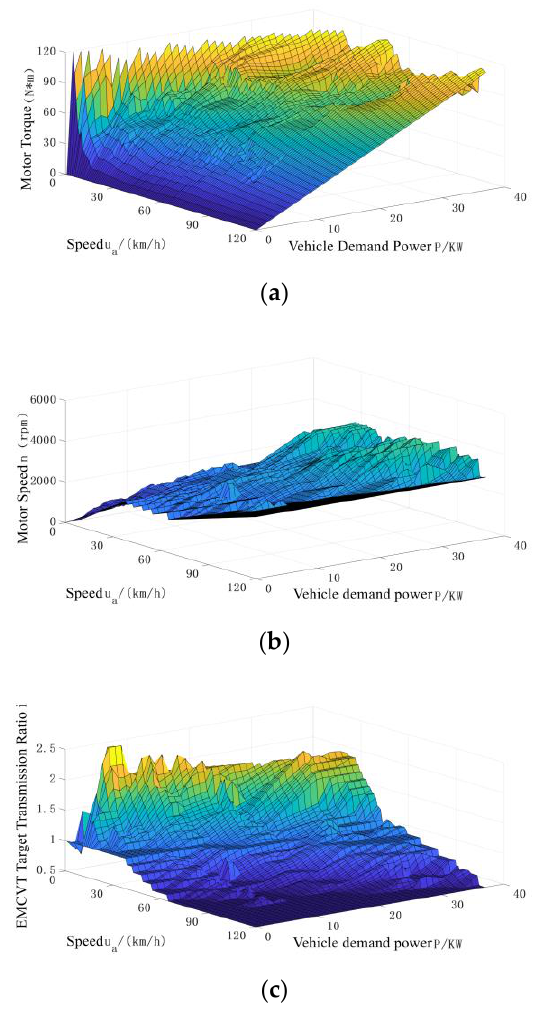
Figure 7. The calculation results for passive control: ( a ) The motor target torque; ( b ) The motor target speed; ( c ) The EMCVT target ratio determined by (a) and (b).